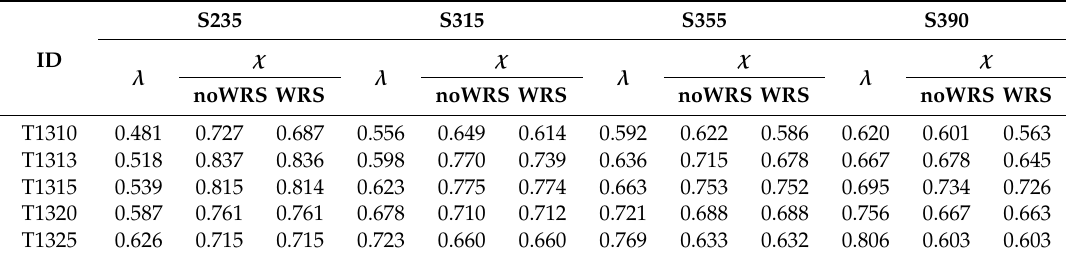
Table A6. Ultimate strength of tee-bar sti ff ened plates made of various